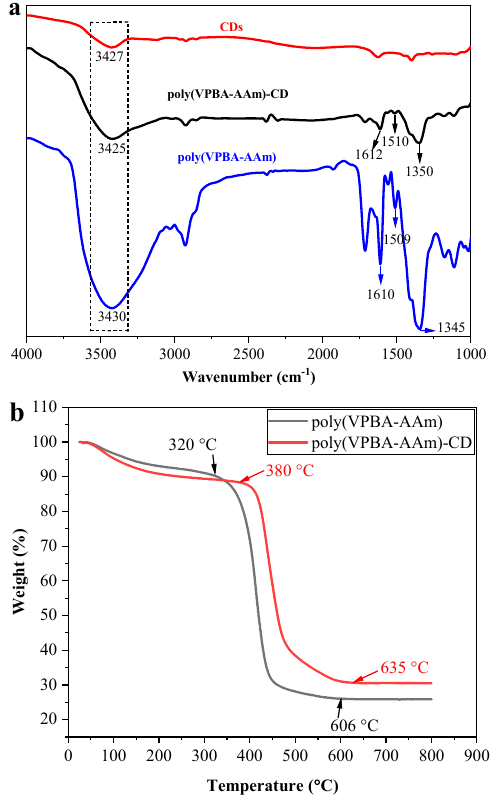
Figure 2. ( a ) FT-IR spectra of free CDs, poly(VPBA-AAm) microgel and poly(VPBA-AAm)-CD hybrid Figure 2. ( a ) FT ‐ IR spectra of free CDs, poly(VPBA ‐ AAm) microgel and poly(VPBA ‐ AAm) ‐ CD hy ‐ brid microgel; and ( b ) TGA curves of poly(VPBA ‐ AAm) and poly(VPBA ‐ AAm) ‐ CD microgels. microgel; and ( b ) TGA curves of poly(VPBA-AAm) and poly(VPBA-AAm)-CD